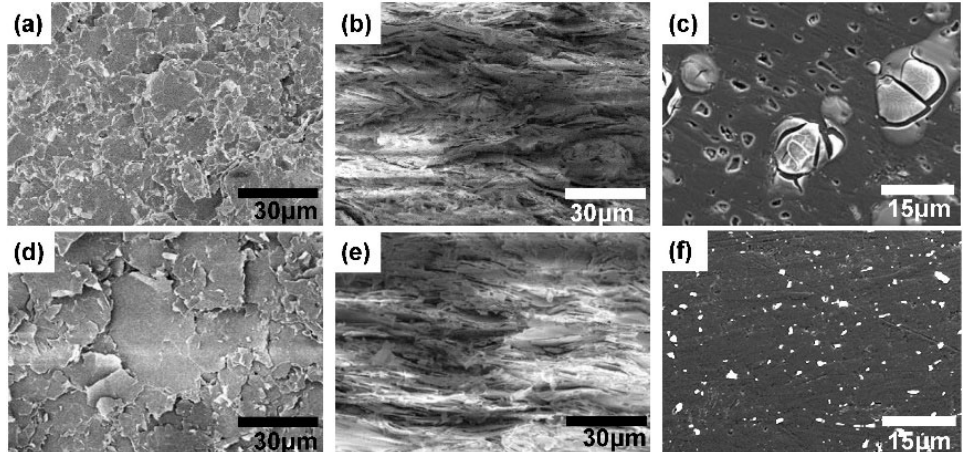
Fig. 32 Fracture morphologies perpendicular (a, d) and parallel (b, e) to the pressure direction and (c, f) polished surfaces perpendicular to the pressure direction of HPed h-BN matrix ceramics with different additives: (a–c) 15 vol% MgO; (d–f) 15 vol% Yb 2 O 3 –MgO. Reproduced with permission from Ref. [127], © Acta Materialia Inc.